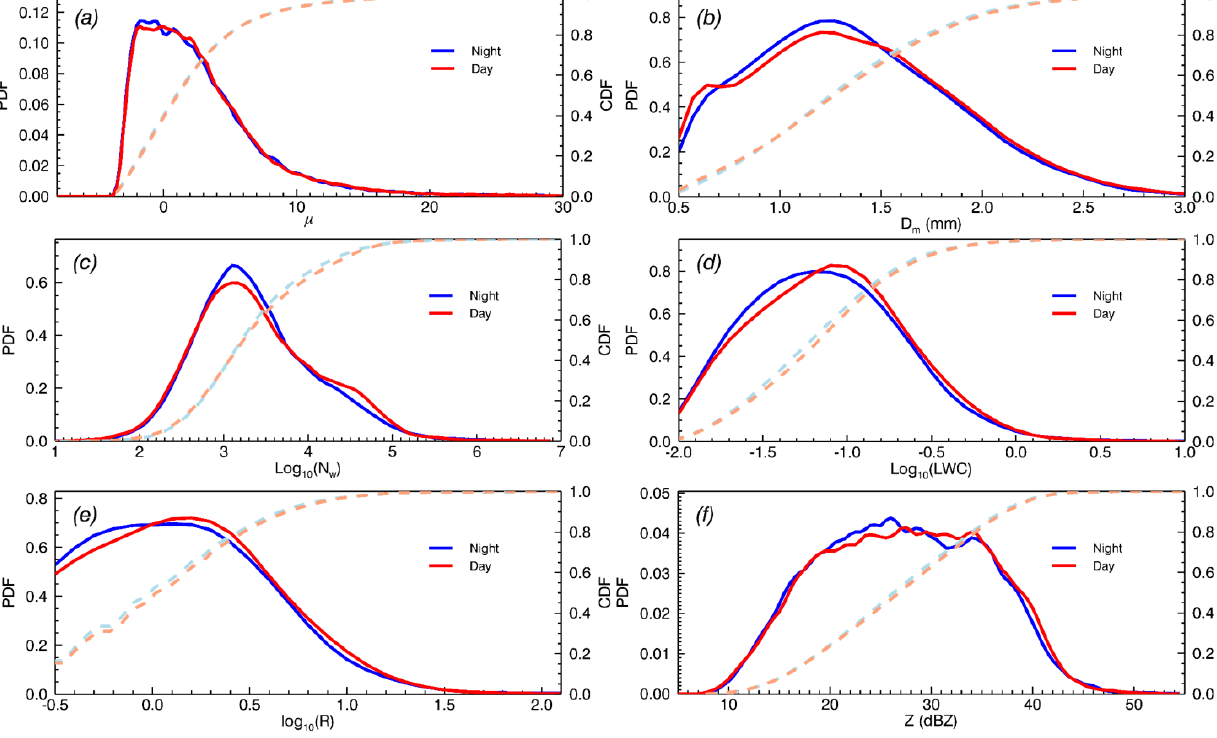
Figure 9. PDF and CDF curves for (a) µ , (b) D m , (c) log 10 (N w ) , (d) log 10 (R) , (e) log 10 ( LWC ) , and (f) Z for DT and NT according to the entire period. The solid red and blue lines represent the PDF for DT and NT, respectively. The broken light red and blue lines represent the CDF for DT and NT, respectively.